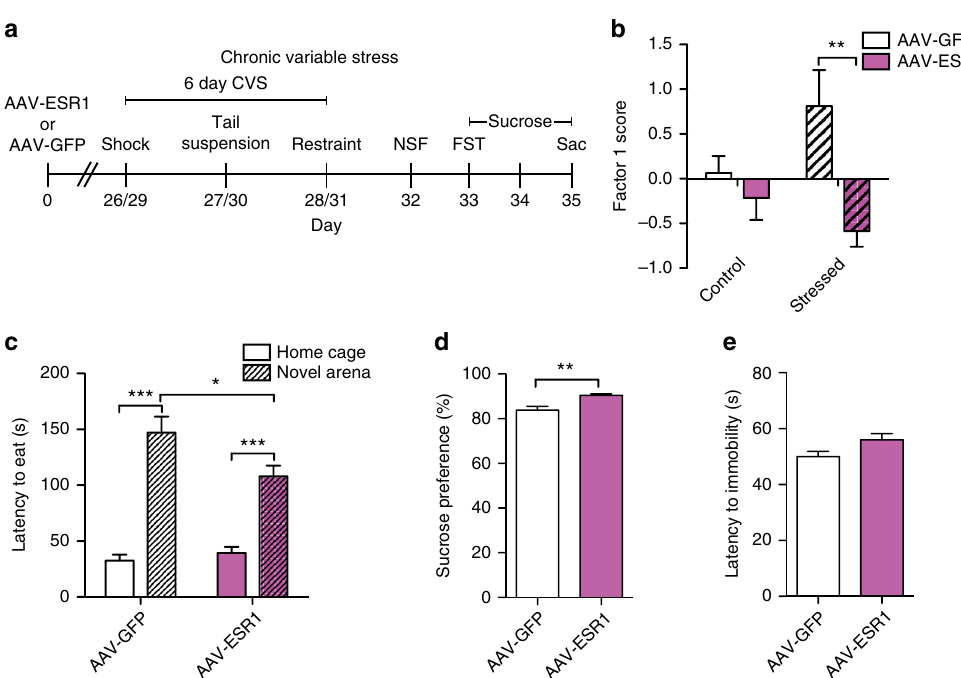
Fig. 4 ER α overexpression in NAc induces antidepressant-like effects in CVS in female mice. a Timeline for CVS experiment. b Virus ( F (1,42) = 10.06, P < 0.003; n = 11,12,11,12), but not stress ( F (1,42) = 0.52, P < 0.478) has a signi fi cant main effect on factor 1 scores. However, there is a signi fi cant stress by virus interaction ( F (1,42) = 4.47, P < 0.040) whereby stressed, but not control, AAV-GFP injected mice have higher factor 1 scores ( P < 0.01). c Mice exposed to CVS take longer to feed in a novel environment than the home cage in the novelty suppressed feeding test ( F (1,20) = 116.13, P < 0.001; n = 11). However, this effect is mediated by virus as there is a signi fi cant virus by arena interaction ( F (1,20) = 7.73, P < 0.014) with AAV-GFP injected mice showing a longer latency to feed in the novel environment than AAV-ESR1 injected mice ( P < 0.05). c , d Stressed AAV-ESR1 mice consume more sucrose ( U = 19.0, P < 0.007, n = 11) and show a non-signi fi cant trend towards a higher latency to immobility ( t = 2.03, P < 0.053; n = 10,11) in the forced swim test than (19) stressed AAV-GFP mice. Data are represented as mean ± SEM. b Two-way ANOVA. c Mixed-model ANOVA. d Independent-samples Mann – Whitney. e Two-tailed t test. * P < 0.05 in c , ** P < 0.01, *** P < 0.001 Bonferroni post hoc for independent